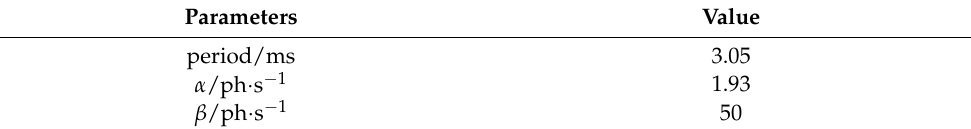
Table 2. Simulation parameters of PSR B1821-24 (Reprinted from [39]).